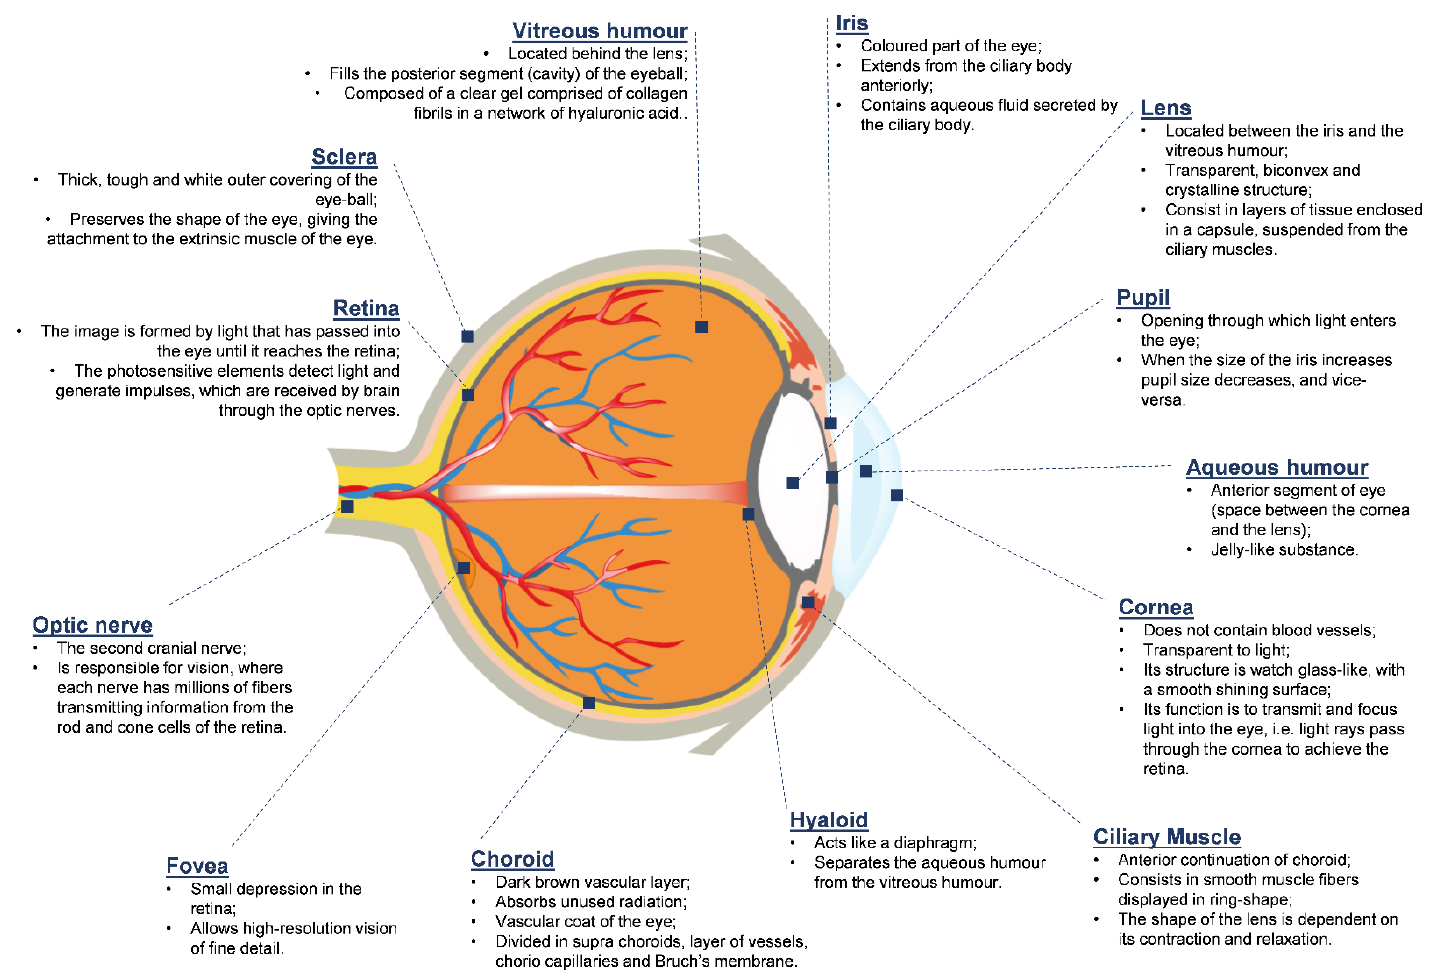
Figure 1. Anatomical and physiological features of the eye structure.